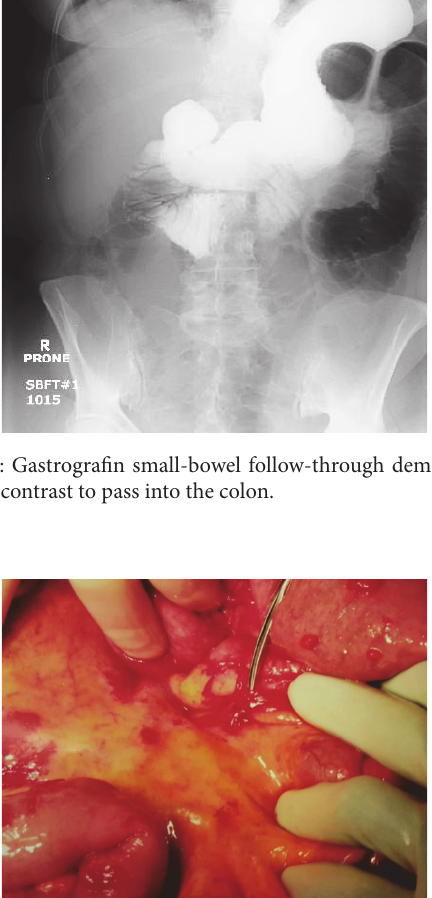
obstruction, perforation, or massive hemorrhage. Monitoring